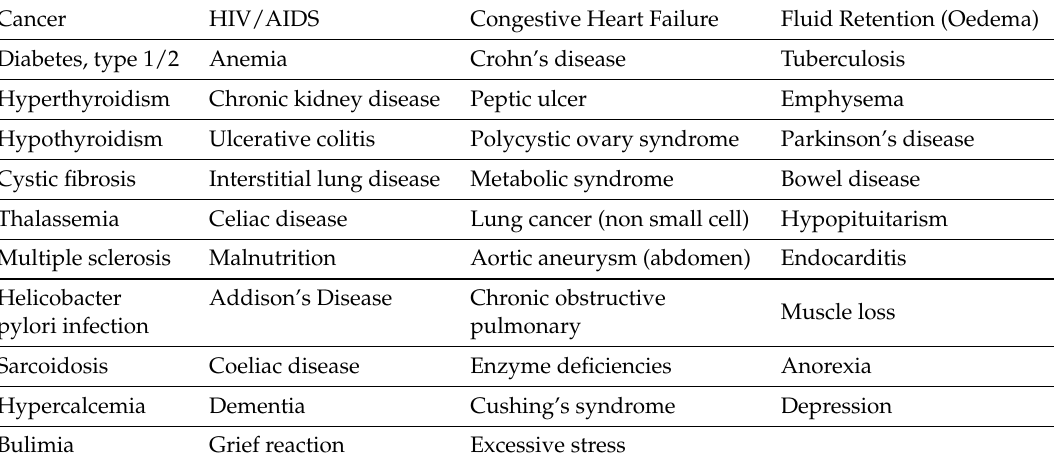
Table 1. Medical Conditions Associated with Weight